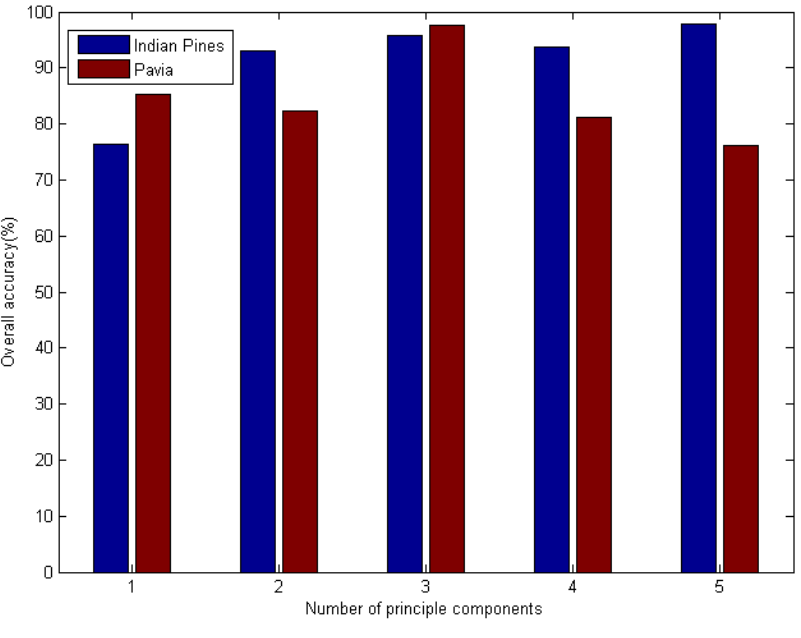
Figure 5. Effect of principal components (SC–DBN classifier). Table 4. Overall accuracy (OA), average accuracy (AA), and kappa coefficients of Indian Pines and Pavia University. SC — spatial classifier; JSSC — joint spectral – spatial classifier; SVM — support vector machine.